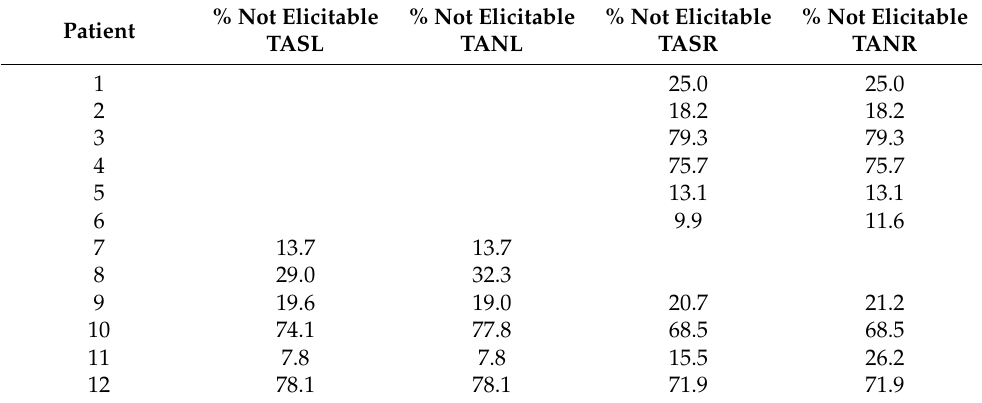
Table 2. Percentage of not elicitable responses per patient with inconsistently elicitable responses in at least one